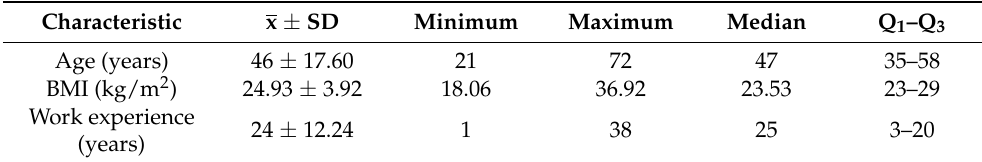
Table 1. Characteristics of the study group.